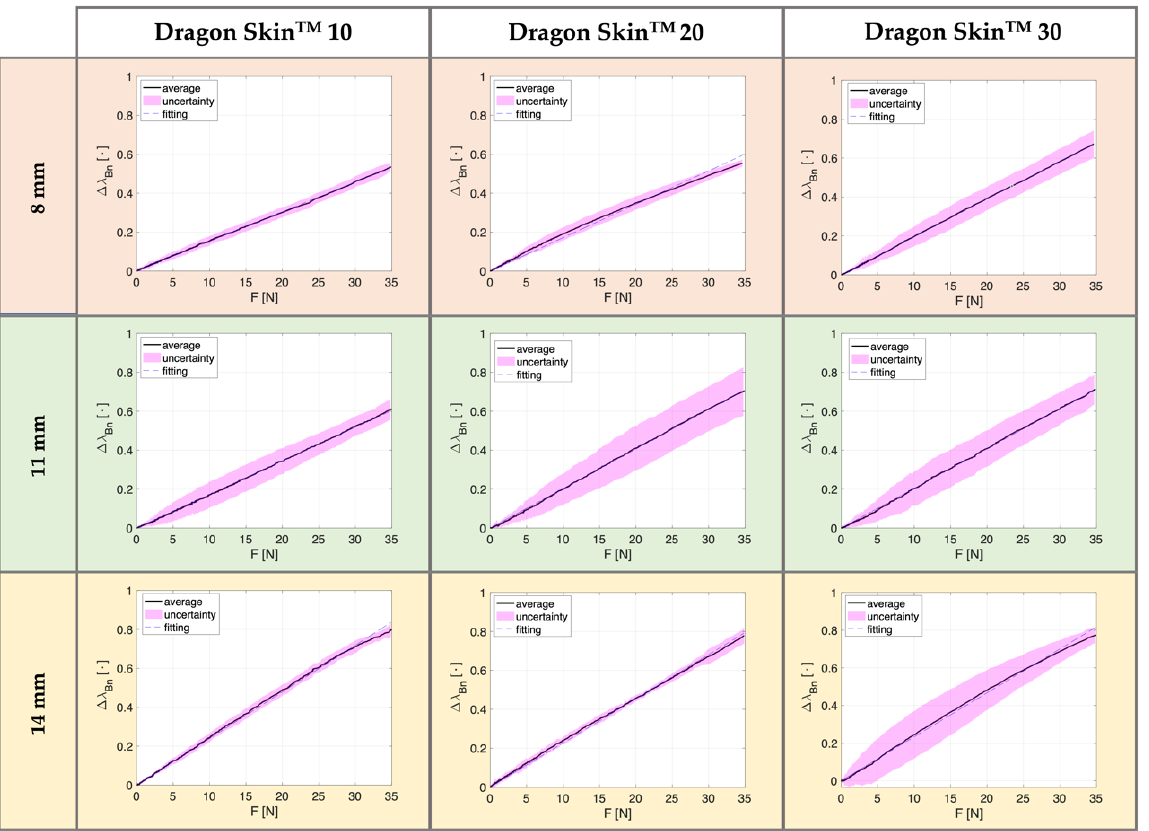
Figure 5. Normalized responses of the SSs (∆λ Bn vs. F) obtained in PT. The three columns distinguish the curves obtained according to the material used (i.e., Dragon Skin TM 10, 20, and 30), and the three rows marked with different colors refer to the thicknesses (8 mm in orange, 11 mm in green, and 14 mm in yellow). In each plot, the continuous black lines represent the average ∆λ Bn vs. F, the highlighted area in magenta represent the related uncertainty, and the dotted blue line represent the linear fitting. Table 3. Maximum percentage ∆ λ Bn recorded for all developed SSs at each configuration (AT and PT), silicone rubber used (Dragon Skin TM 10, 20, and 30), and thickness (8 mm, 11 mm, and 14 mm). Dragon Skin TM